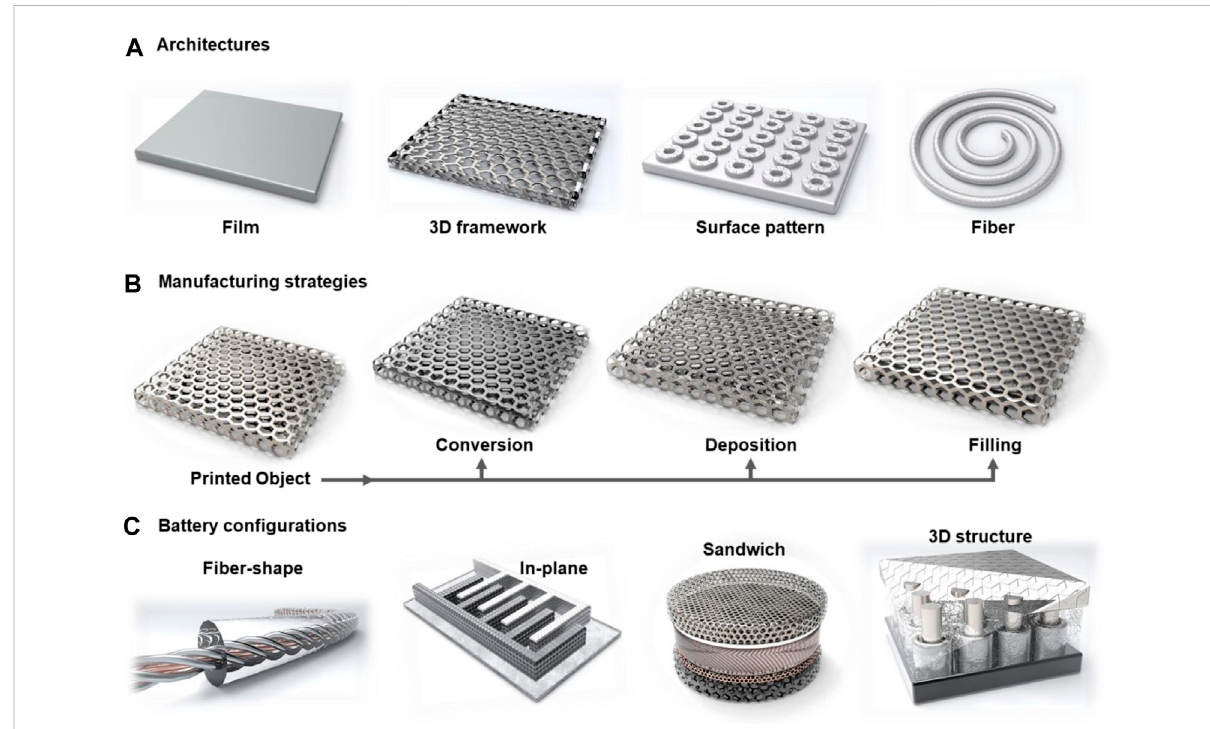
FIGURE 2 Schematic illustration of design principles of 3D-Prined Batteries. (A) Diverse architectures of printed battery modules. (B) Manufacturing strategies of printed battery modules. (C) Typical con fi gurations of printed